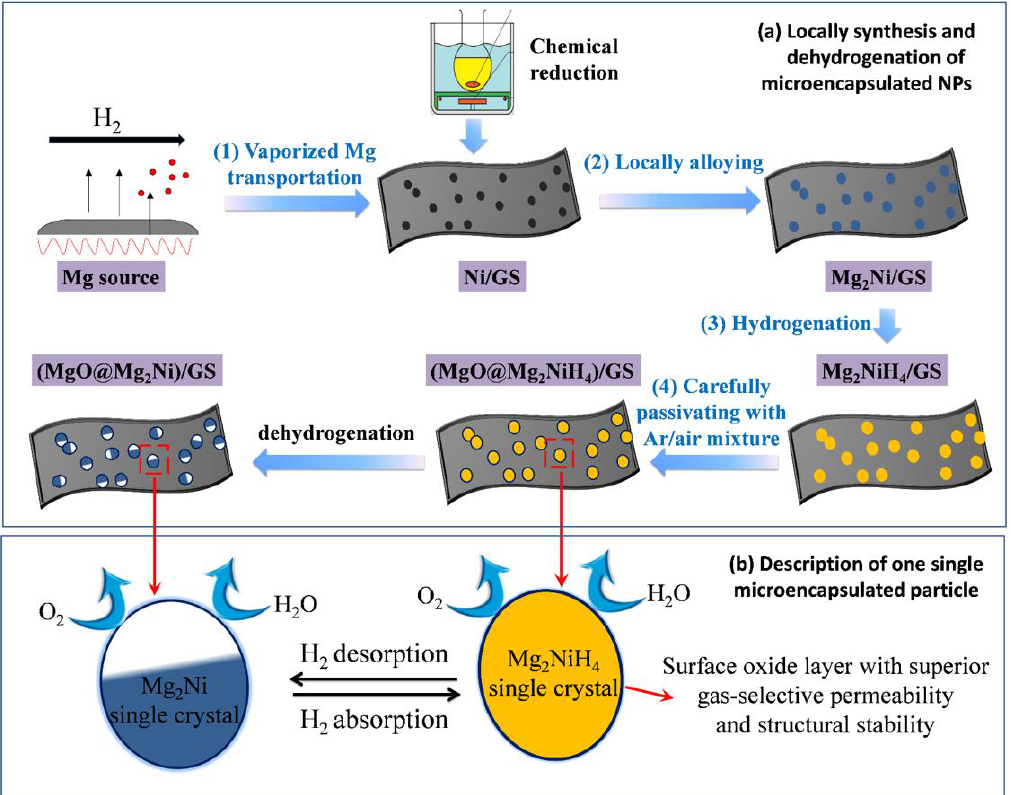
Figure 8. Schematic of ( a ) the local synthesis of monodispersed Mg 2 NiH 4 nanoparticles locally derived from Ni/GS by HCVD and the structural evaluation after hydrogen desorption. Four steps are involved in the HCVD synthesis: (1) under H 2 atmosphere, gasified Mg transports to the Ni/GS substrate; (2) the Ni dopants act as positive cores to attract gaseous Mg atoms, and the alloying reaction between them locally generates monodispersed Mg 2 Ni NPs on the GS surface; (3) Mg 2 Ni absorbs H 2 and transforms to Mg 2 NiH 4 ; (4) careful in situ passivation of the NPs to form an MgO coating with a thickness of ~3 nm occurs during the cooling process. ( b ) Detailed description of a single microencapsulated particle. A “semi-hollow” structure is formed upon hydrogen desorption. Adapted with permission from [64], Copyright Wiley, 2017.